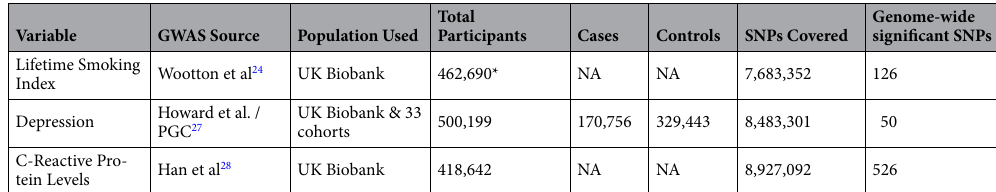
Table 1. Characteristics of the GWAS from which the summary statistics were obtained. NA: Not applicable as continuous variable. *249 318 never smokers, 164 649 former smokers and 48 723 current